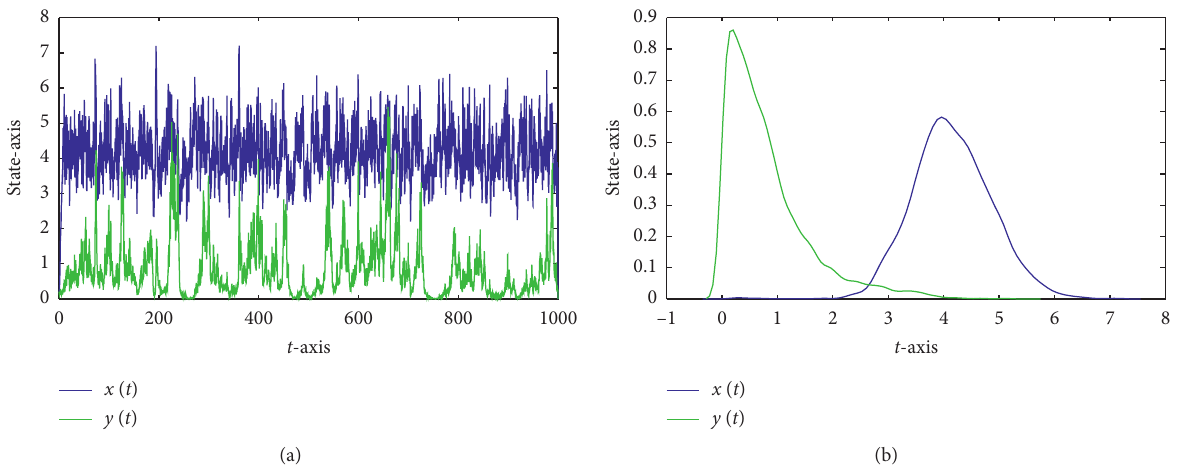
Figure 4: The stationary distribution of switching systems (39) and (40) with π � ( 0 . 4 , 0 . 6 ) . (a) The time series graph of ( x ( t ) and y ( t ) ). (b) The density graph of ( x ( t ) and y ( t ) ).